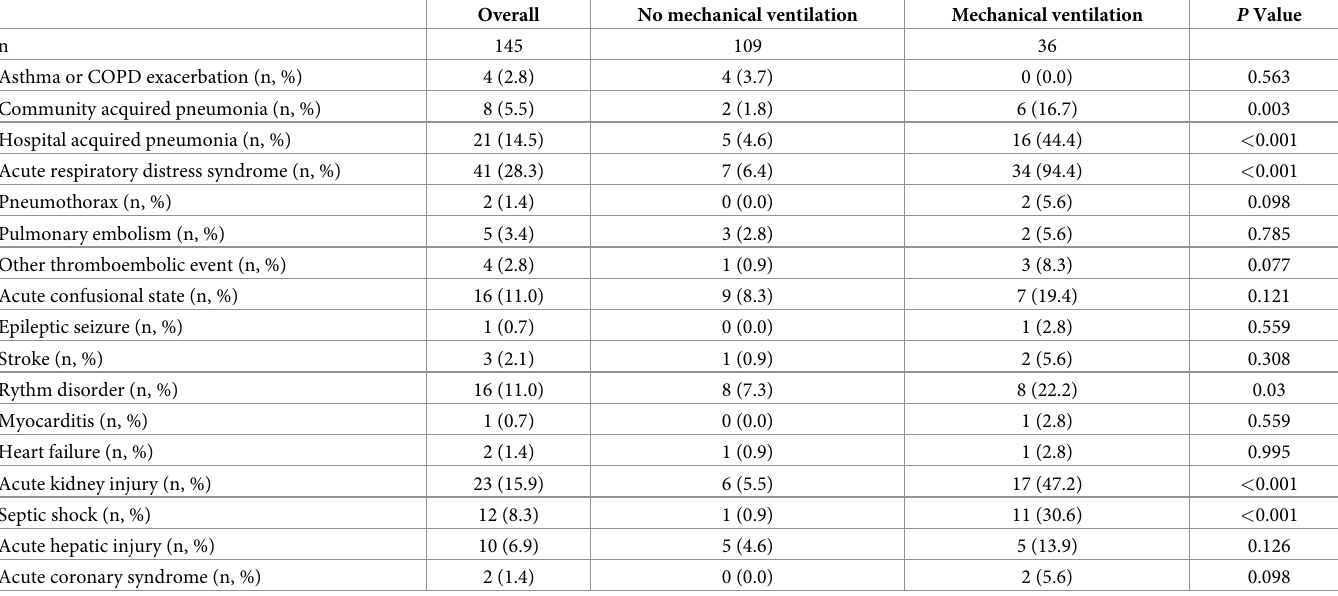
Table 7. Complications during the follow-up period.